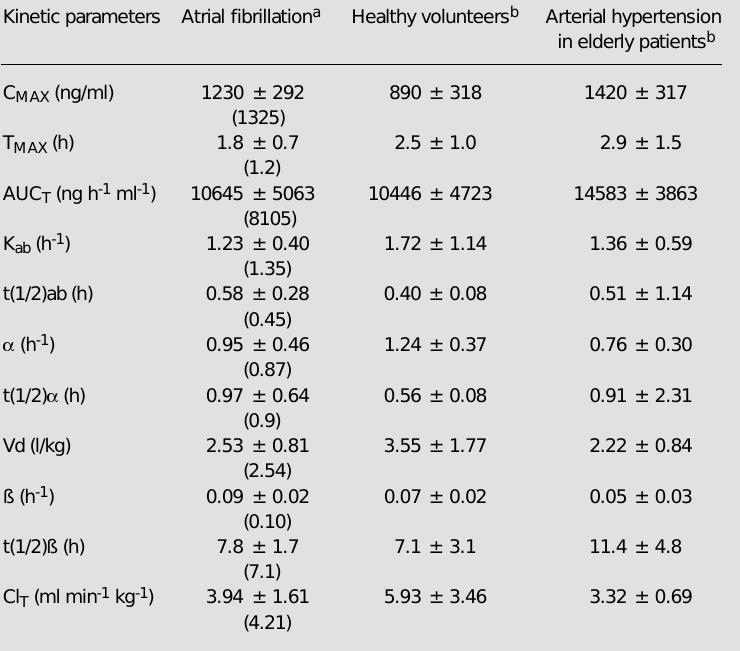
distribution and elimination, respectively; Vd AREA : apparent volume of distribution; K ab : absorption rate constant; t(1/2)ab: absorption half-life; t(1/2) a : distribution half-life; t(1/2)ß: biological half-life; Cl T : plasma clearance. a Patients (atrial fibrillation), present study; b elderly hypertensive patients and healthy volunteers (9). Kinetic parameters Atrial fibrillation